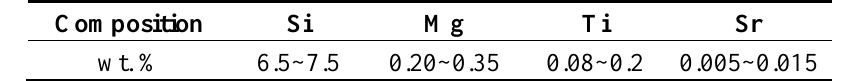
Table 1. Chemical compositions (wt. %) of the improved aluminum alloy type A356.